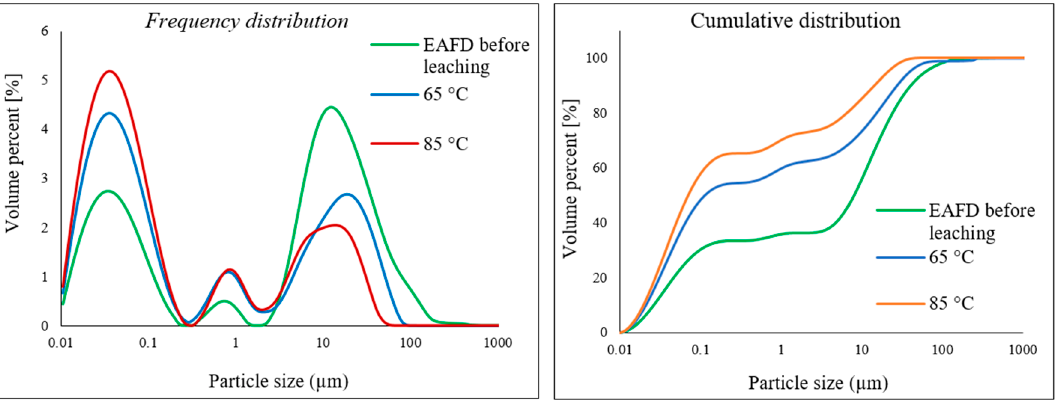
Figure 18. Comparing the PSD of the EAFD before leaching and the particles leached in 30% v/v [Bmim + HSO 4 − ] solution at 65 and 85 °C.